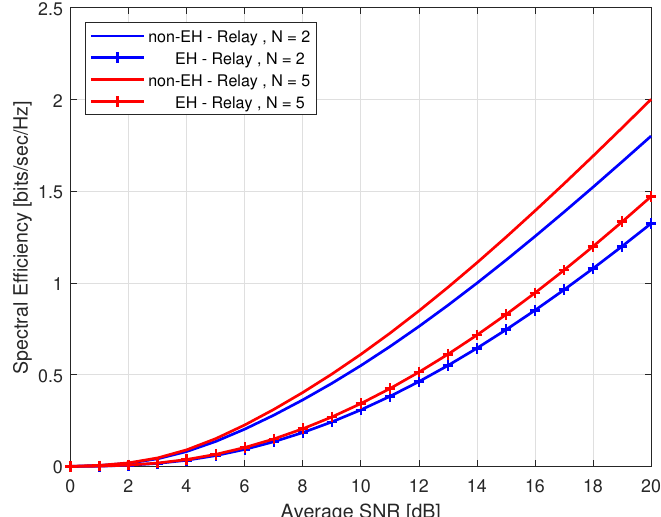
Figure 7. SE of conventional and wireless energy harvesting (WEH) relaying for the best relay selection (BRS)